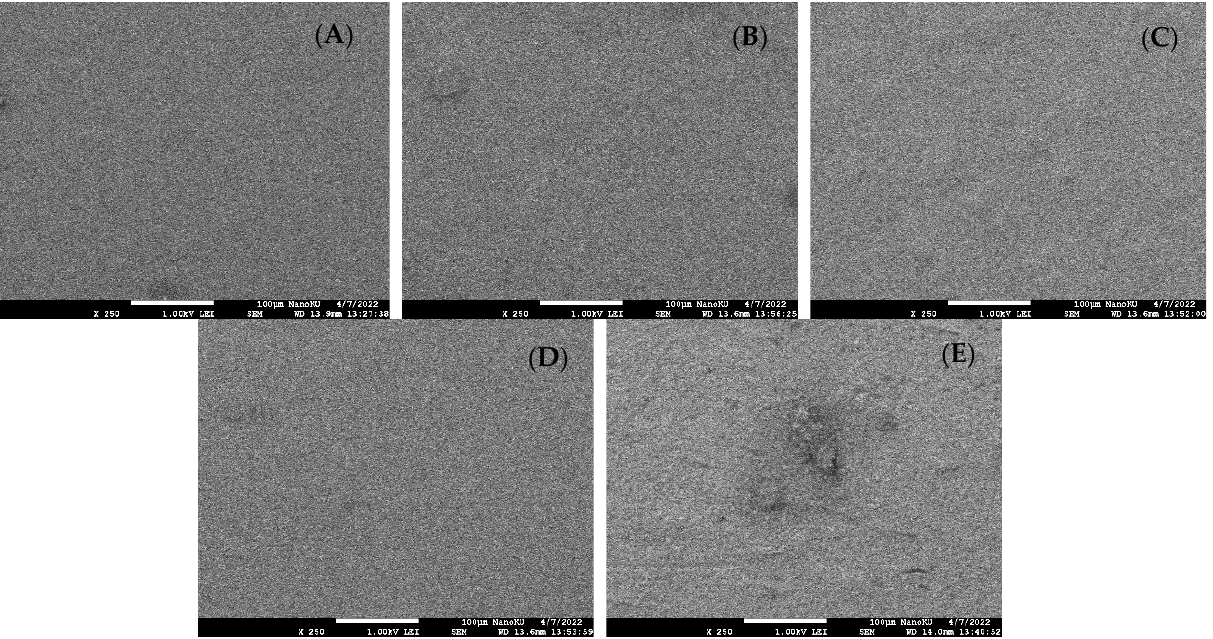
Figure 2. Surface morphology of PVA composite film: ( A ) Neat PVA; ( B ) 80PVA/20LN; ( C ) 60PVA/40LN; ( D ) 40PVA/60LN; ( E ) 20PVA/80LN.